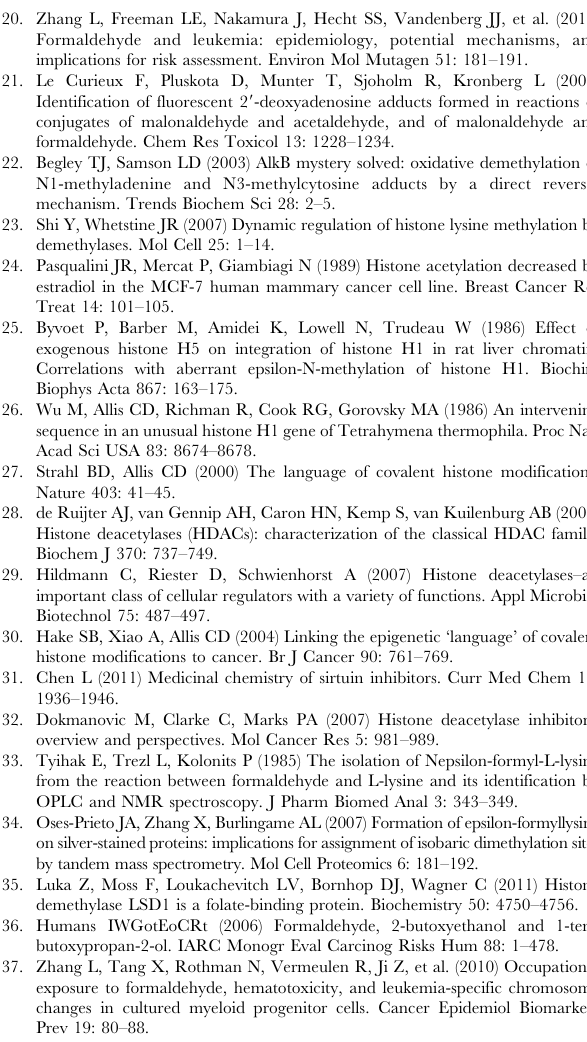
spectrometer, as described in Materials and Methods . An exception was lysine, for which the 130 m/z ion was selected due to lysine’s high abundance compared to other species monitored. (TIF) Figure S4 Examples of calibration curves for the isotope- dilution LC-MS/MS analysis of modified lysine species, as described in Materials and Methods . Abbreviations: FK, N 6 - formyllysine; DFK, deuterium-labeled N 6 -formyllysine; AK, N 6 - acetyllysine; DAK, deuterium-labeled N 6 -acetyllysine; K, lysine; DK, deuterium-labeled lysine; MK, N 6 -mono-methyllysine; M 2 K, N 6 -di-methyllysine; M 3 K, N 6 -tri-methyllysine.